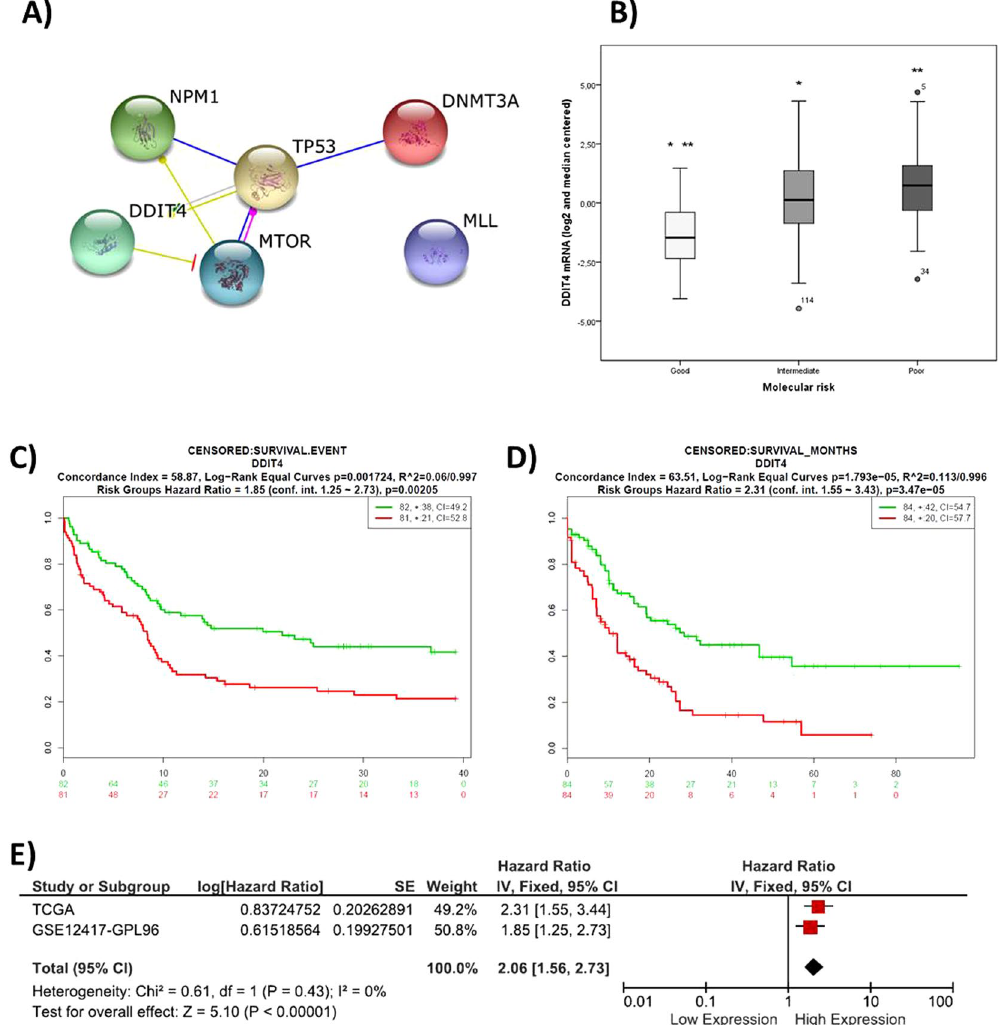
Figure 1. Evaluation of DDIT4 in the survival of AML patients. ( A ) Protein interaction of DDIT4 and genes related with the outcome in AML. ( B ) DDIT4 is associated with the molecular risk in AML patients (P < 0.001). Survival analysis of AML patients stratified by DDIT4 expression in datasets contained in SurvExpress show that high DDIT4 expression (over the median) is associated to a poor prognosis in the ( C ) TCGA dataset [N = 168] and in ( D ) GSE12417 − GPL96 dataset [N = 168]. ( E ) A meta-analysis in these two datasets shows 2.6 times increasing in death risk in AML patients with high DDIT4